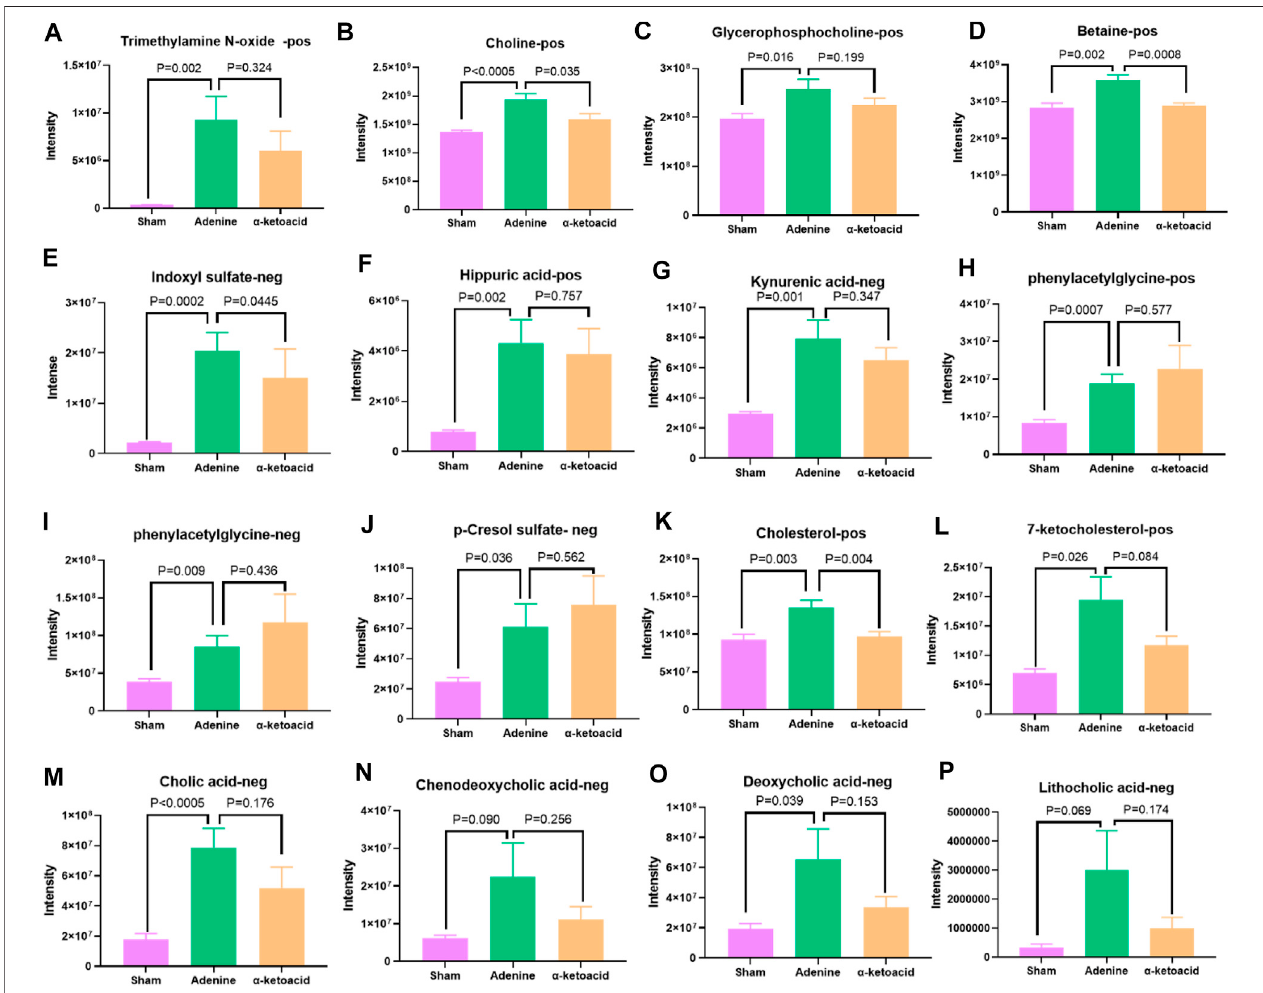
FIGURE 6 | α -ketoacid altered serum metabolites of uremic toxins and bile acids in adenine-induced CKD rats. (A) trimethylamine N-oxide. (B) choline. (C) phosphatidylcholine. (D) betaine. (E) indoxyl sulfate. (F) hippuric acid. (G) kynurenic acid. (H) phenylacetylglycine. (I) phenylacetylglutamine. (J) p-cresol sulfate. (K) cholesterol . (L) 7-ketocholesterol. (M) cholic acid. (N) chenodeoxycholic acid. (O) deoxycholic acid. ( P ) lithocholic acid. Data are presented as the means ± standard error of the mean. n (cid:1) 8 rats per group. A value of p < 0.05 was considered statistically signi fi cant by Welch ’ s t test.